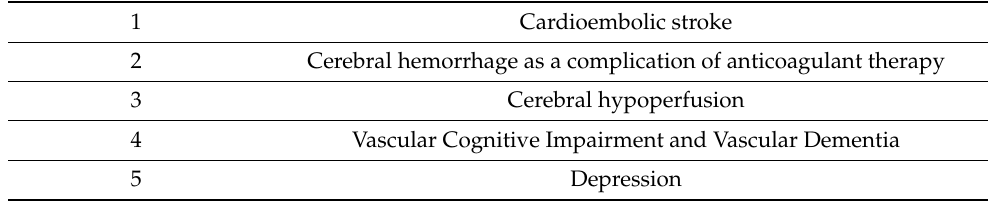
Table 4. Potential Effects of Atrial Fibrillation on the